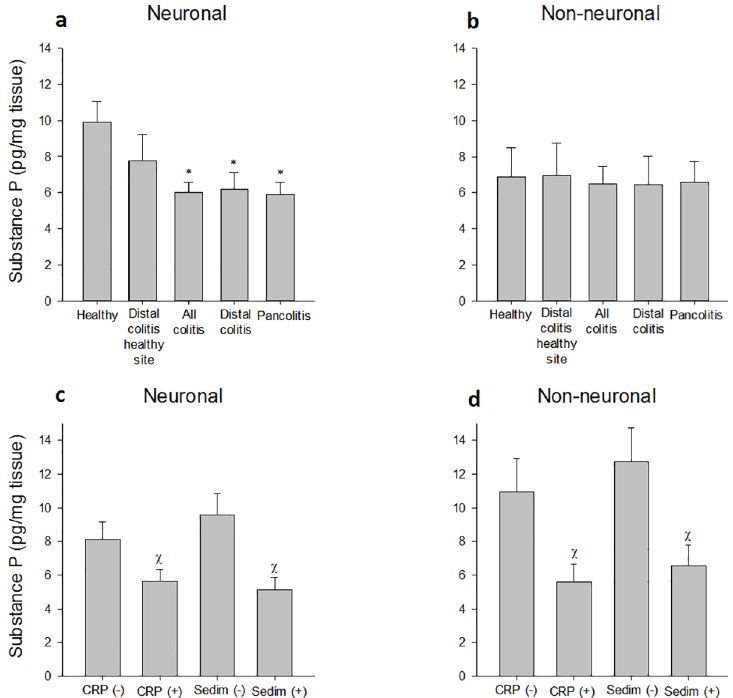
Healthy controls and healthy tissue samples of distal colitis had similar levels of neuronal and non-neuronal VIP. Samples from patients with distal colitis and pancolitis had lower neuronal and non-neuronal VIP when compared with the control group. Active inflammatory sites of patients with distal colitis had lower VIP compared to healthy tissue samples of distal colitis (Fig 3A and 3B). Subgroup analyses for age, gender, CRP positivity, sedimentation positivity and new diagnosis/ reactivation were similar.